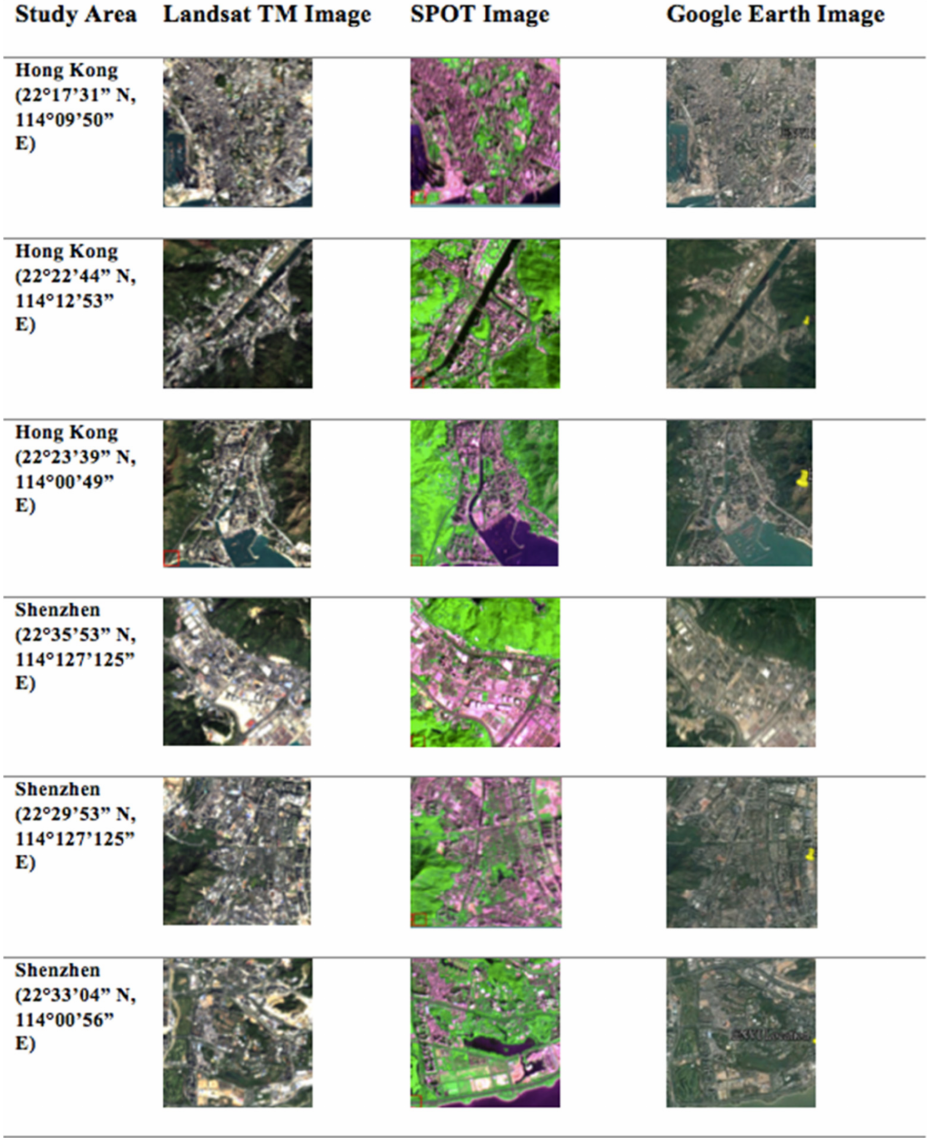
Figure 11. Random samples of Landsat TM, SPOT, and Google Earth images. A total of 100 random-sampling, 3 × 3 pixel Landsat TM data were chosen for com- parison with the equivalent location of Google Earth images (Figure 12), which shows the residual analysis and calculated RMSE and MAE of impervious surface estimation in 1995, 2005, and